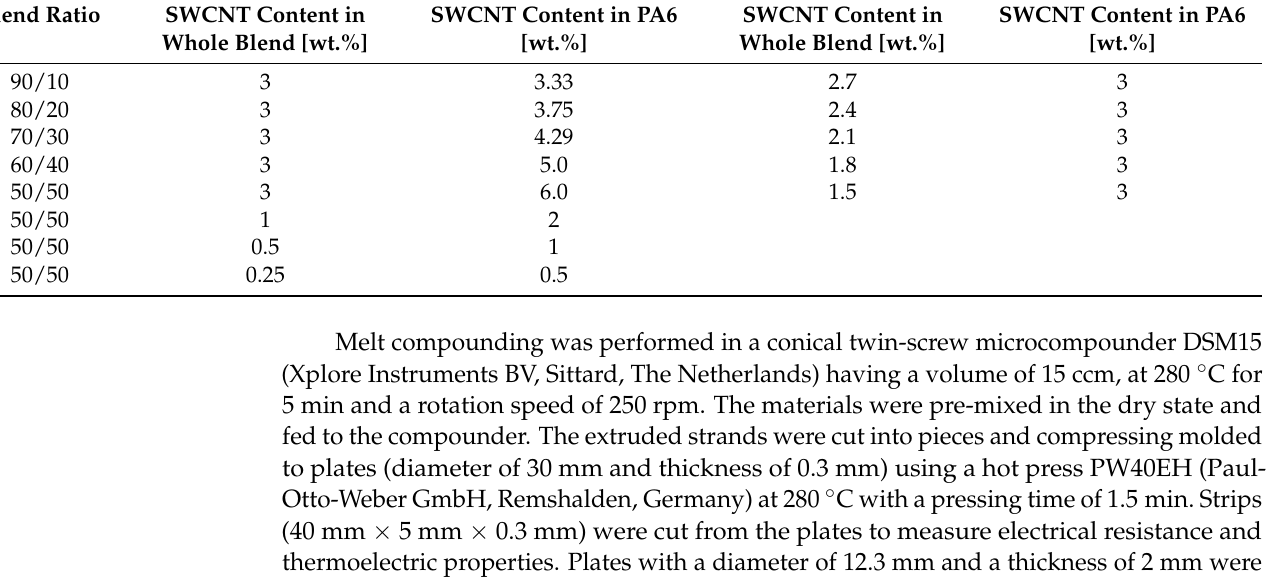
Table 1. SWCNT concentration in whole blend and in the PA6 component in dependence on blend composition. Set 2 Set 1 Set 1 SWCNT Content in SWCNT Content in PA6 Blend Ratio SWCNT Content in Whole Blend [wt.%] Whole Blend [wt.%]